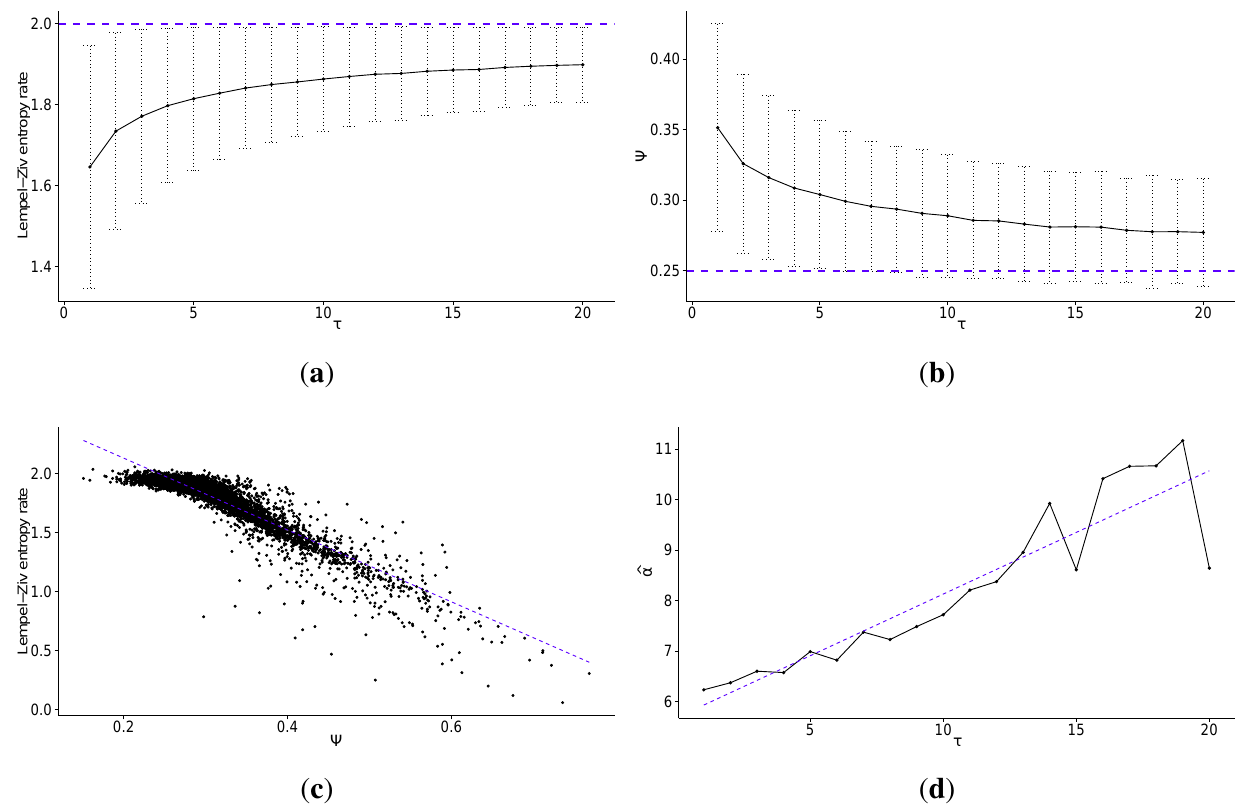
Figure 1. Multiscale analysis of transaction level logarithmic price change history for 707 stocks from the Warsaw Stock Exchange sampled every (cid:28) price changes, discretized into four quantiles: (a) the average Lempel–Ziv entropy rate among studied stocks as a function of scale (cid:28) (the dotted line denotes the maximum for fully efficient/unpredictable market; error bars show (cid:6) one standard deviation); (b) the percentage of times the Maximum Entropy Production Principle correctly guesses the quantile of the next price change ( Ψ ) averaged over all studied stocks as a function of scale (cid:28) (the dotted line denotes the value which would be obtained with random guessing; error bars show (cid:6) one standard deviation); (c) the correlation between the Lempel–Ziv entropy rate and Ψ for all studied stocks and scales (the dotted line shows a linear fit); (d) the scaling parameter of the power law fitted for Ψ as a function of scale (cid:28) (the dotted line shows a linear fit). We observe that the predictability of the stock price changes decreases fast with increasing time scale, both with regard to theoretical measure of Lempel–Ziv entropy and practical test for the Maximum Entropy Production Principle. In fact the Pearson’s correlation coefficient between these two measures is (cid:0) 0 : 9256 for all studied scales. Further, we observe that in general the scaling parameter of the power law fitted to the tails of the distributions of Ψ increases with the time scale (cid:28) , that is the predictability decays faster for larger values of (cid:28)